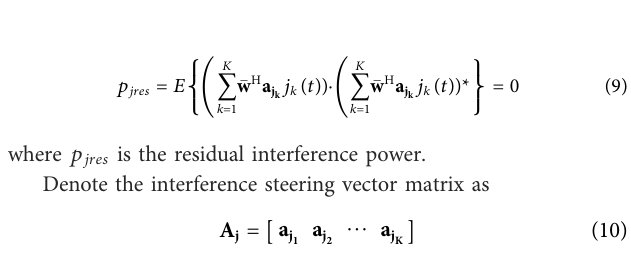
FIGURE 1 Article structure block diagram.